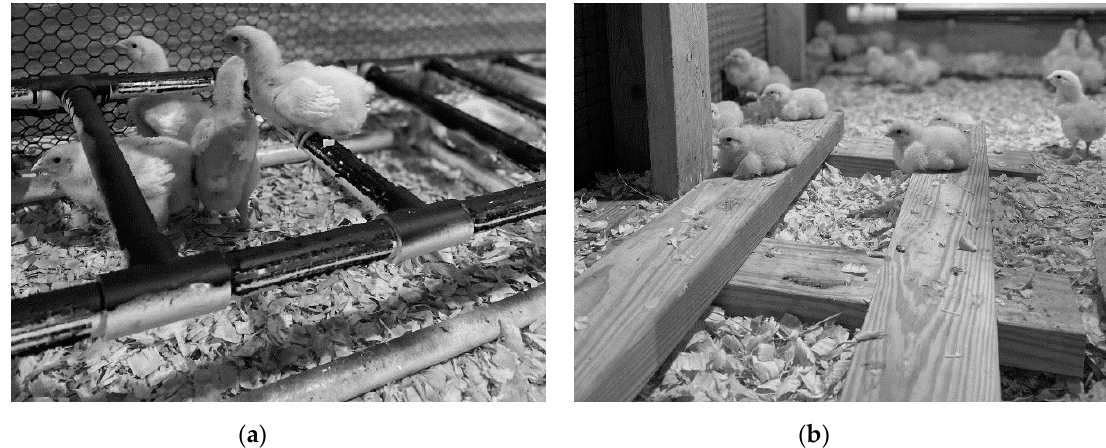
Figure 2. Photograph of the perch design in high-complexity pens in ( a ) Experiment 1 ( n = 3/pen) and ( b ) Experiment 2 ( n = 3/pen).